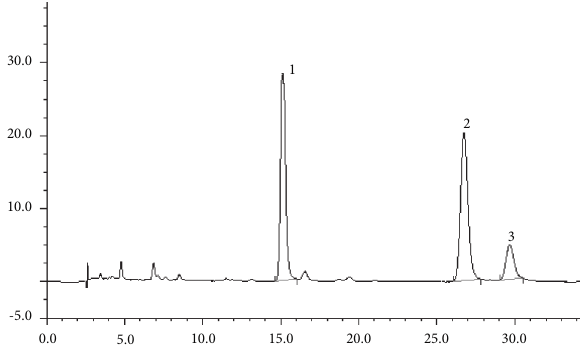
Figure 5: HPLC chromatograms of sample. Note: 1, euphorbia factor L3; 2, euphorbia factor L1; 3, euphorbia factor L4.